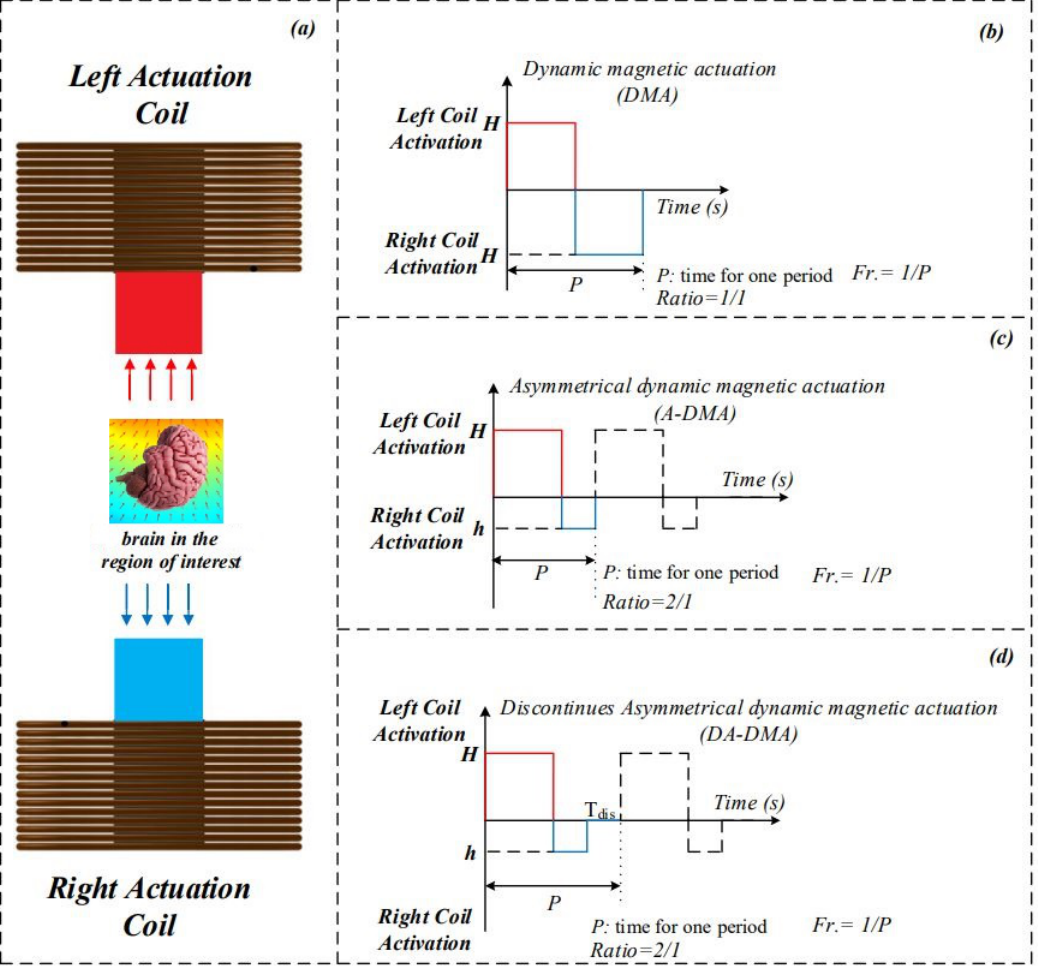
Figure 1. The magnetic actuation schemes; ( a ) two electromagnets are positioned on the right and left side of the brain providing a strong magnetic field; ( b ) the dynamic magnetic actuation with equal magnetic intensity (H, Fr.) [20]; ( c ) the asymmetrical dynamic magnetic actuation (A-DMA) with unequal magnetic intensity (H, h, Fr.) [28]; ( d ) the discontinuous asymmetrical dynamic magnetic actuation (DA-DMA) with unequal magnetic intensity and discontinuity (H, h, Fr., T dis )